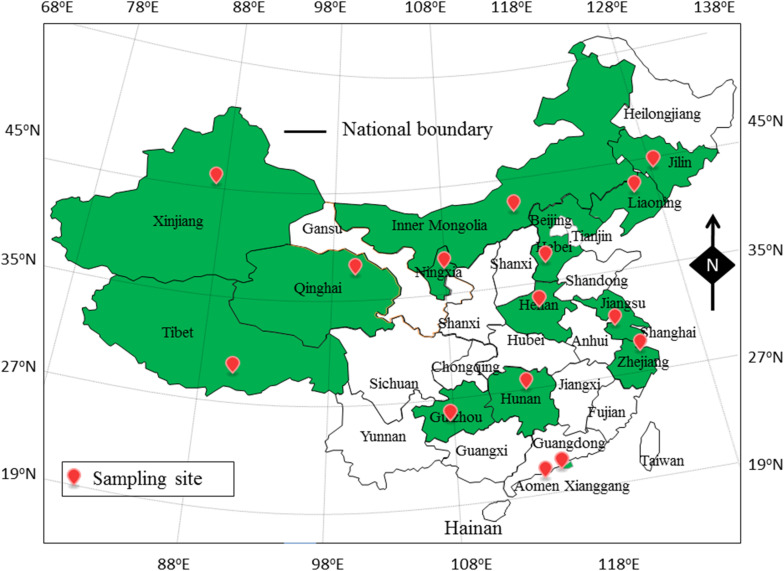
The sampling site of foods sample in China.